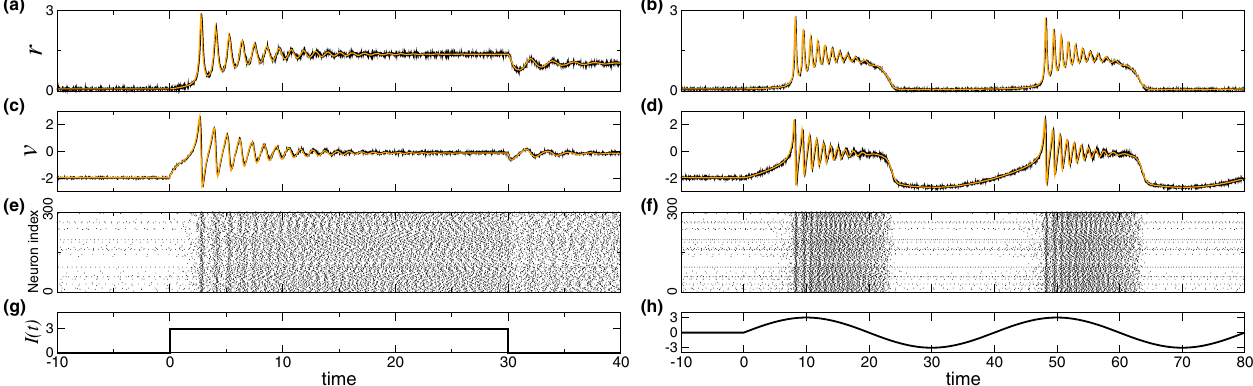
FIG. 2. The transient dynamics of an ensemble of QIF model neurons [Eqs. (1) and (2)] are exactly described by the FREs (12). (a),(b) Instantaneous firing rate and (c),(d) mean membrane potential of the QIF neurons and the FREs are depicted in black and orange, respectively. (e),(f) Raster plots of 300 randomly selected QIF neurons of the N ¼ 10 4 in the ensemble. (a),(c),(e),(g) At time t ¼ 0 , a current I ¼ 3 is applied to all neurons, and set to zero again at t ¼ 30 ; stimulus I ð t Þ shown in (g). (b),(d),(f),(h) At time t ¼ 0 , a sinusoidal current is applied to all neurons I ð t Þ ¼ I 0 sin ð ω t Þ , with I 0 ¼ 3 , ω ¼ π = 20 ; stimulus I ð t Þ shown in (h). Parameters: J ¼ 15 , ¯ η ¼ − 5 ; Δ ¼ 1